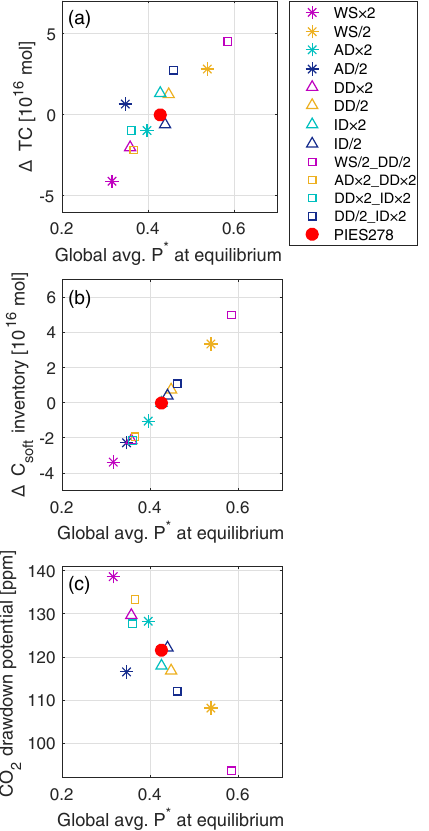
Figure 8. Panels showing (whole) global ocean P ∗ for the differ- ent ensemble members SE1–SE12 plotted versus (a) change in to- tal carbon inventory ( (cid:49) TC, 10 16 mol), (b) the inventory change in C soft , hence M o · (cid:49)C soft (10 16 mol), and (c) the CO 2 drawdown potential (ppm) of each ensemble member, which is the lowering of p CO atm achieved by maximising biological efficiency (making 2 P ∗ equal 1); see Eq. (1). Ensemble member characteristics are de- scribed in Table